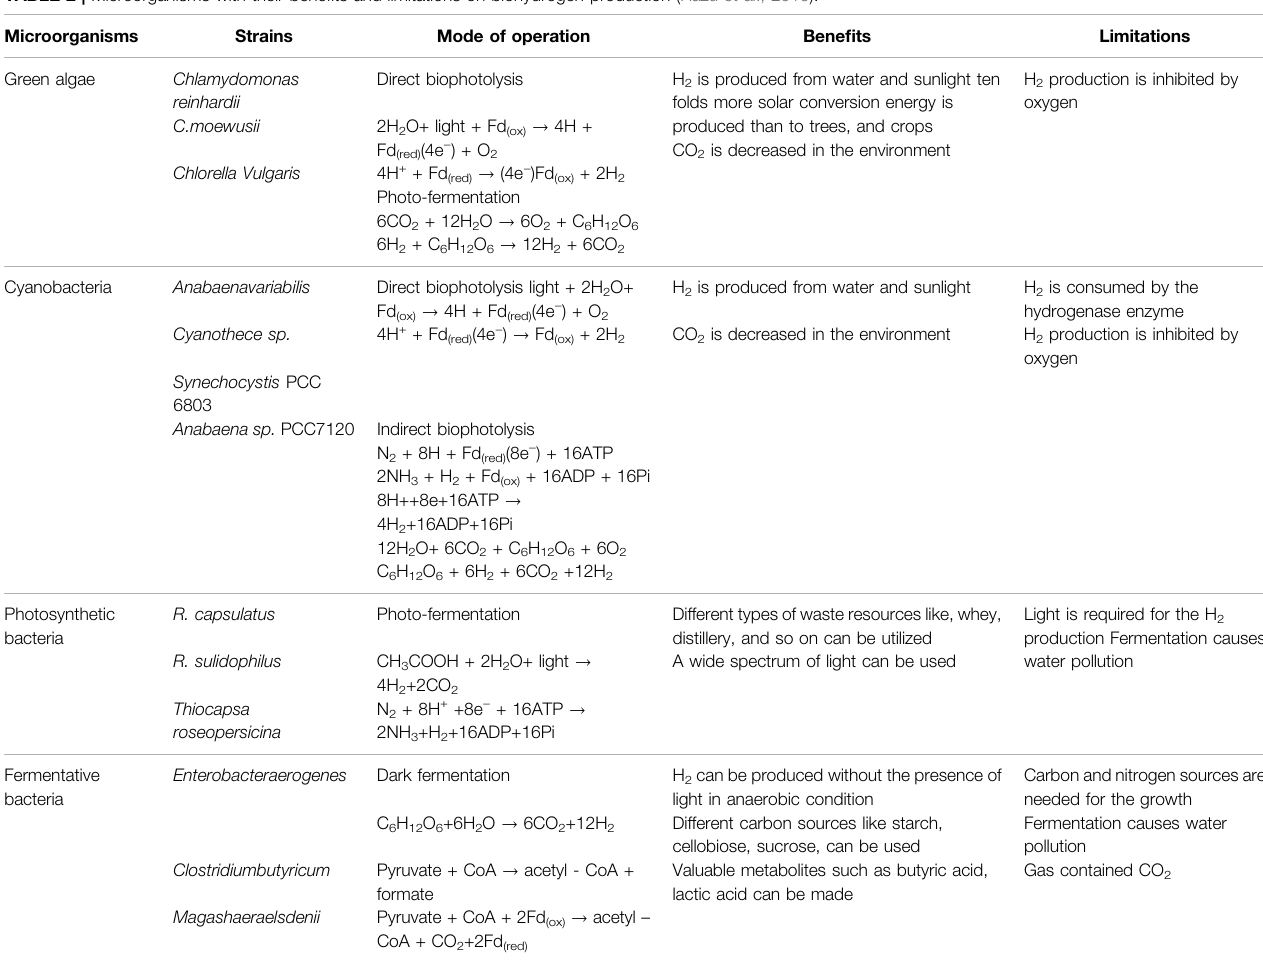
TABLE 2 | Microorganisms with their bene fi ts and limitations on biohydrogen production (Razu et al., 2019).